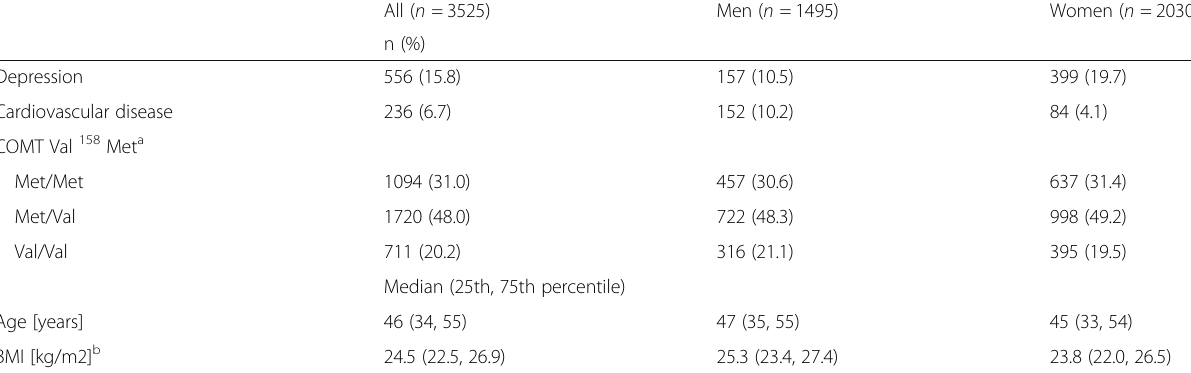
Table 1 Distribution of COMT Val 158 Met, depression and cardiovascular disease (CVD), stratified by gender All ( n =